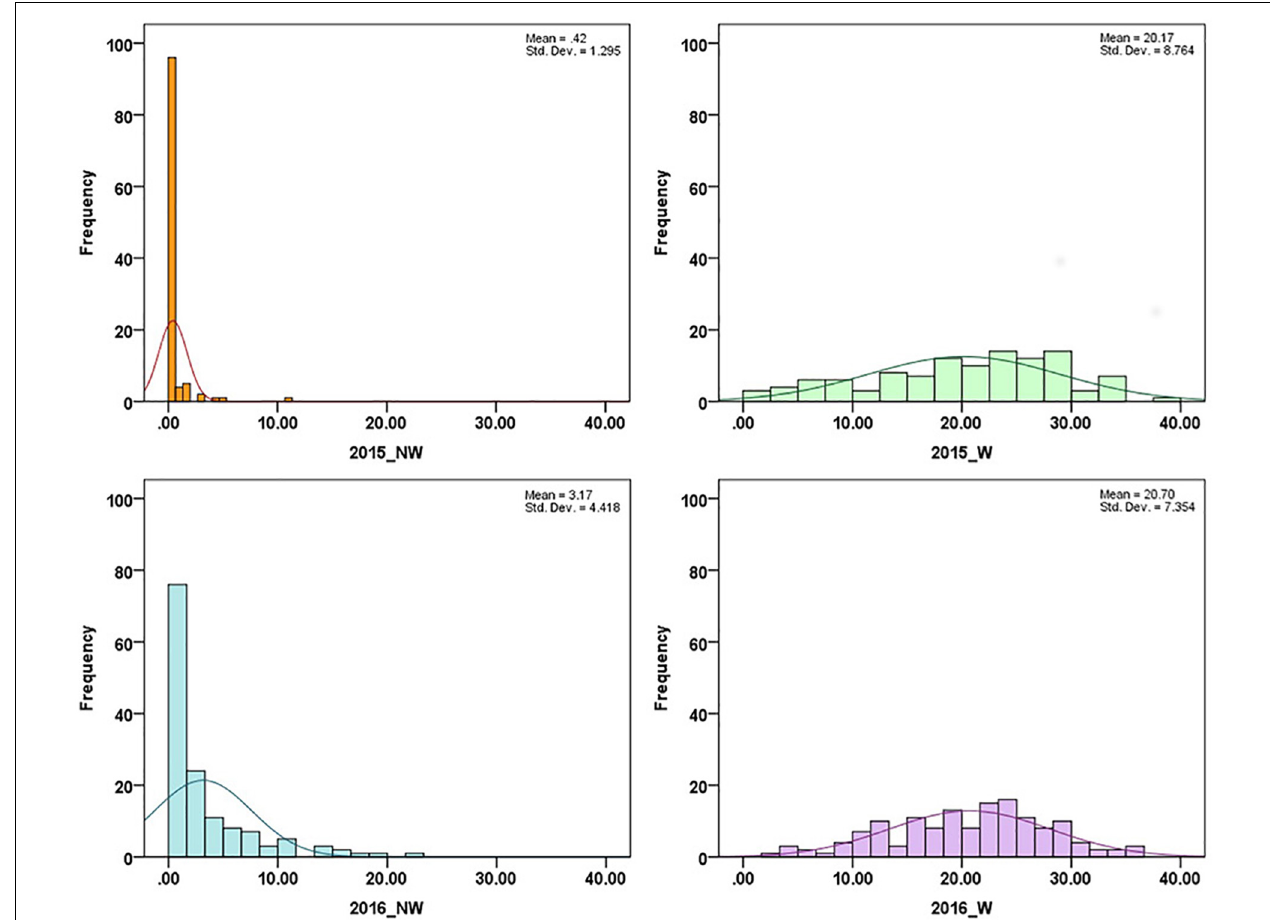
FIGURE 1 | Disease severity index (DSI) distribution in association panels under non-wounded (NW) and wounded (W) treatment in 2015 and 2016.